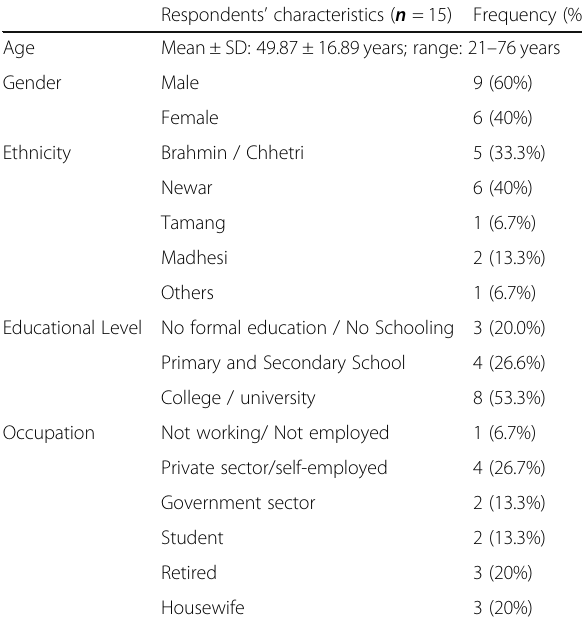
Table 1 Patient Characteristics ( n =